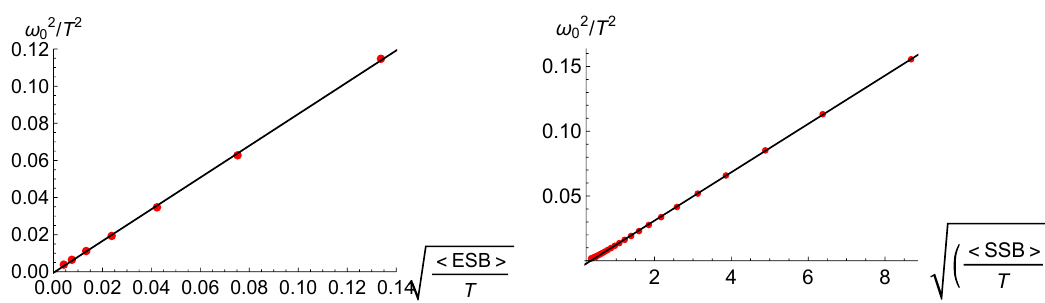
Figure 6 . The dependence of the pinning frequency ω 0 on the ESB and SSB scales. Left : we have √ √ fixed λ ∈ [1 × 10 − 11 , 1 × 10 − 5 ] , T/ ρ = 0 . 15 , α/ ρ = 1 and K = − 1 / 8 . Right : we have fixed √ √ T/ ρ ∈ [0 . 06 , 0 . 30] , α/ ρ = 1 , λ = 1 × 10 − 8 and K = − 1 / 8 . The black lines indicate linear